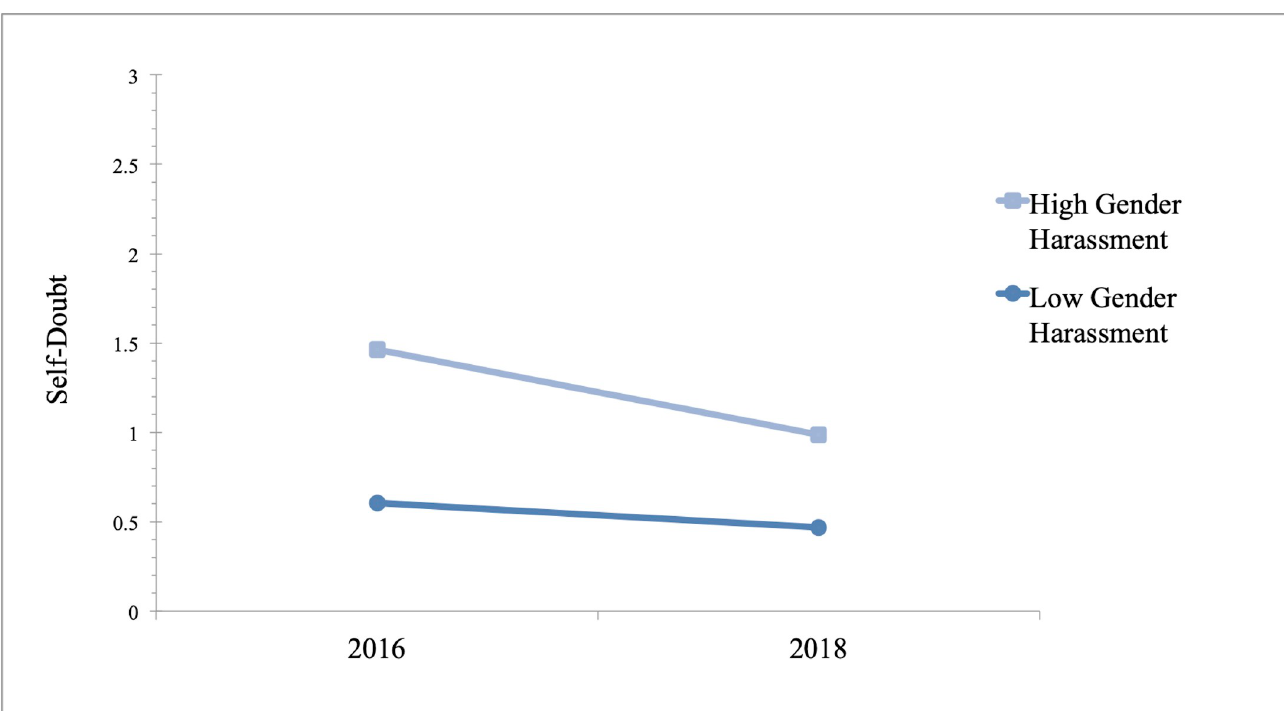
Fig 4. Coefficient estimates for relationship between gender harassment ( ± 1 SD) and self-doubt in 2016 and in 2018. Estimates are derived from GLM using data from 513 women, 250 of whom were surveyed in September 2016 and the remaining women were surveyed in September 2018.